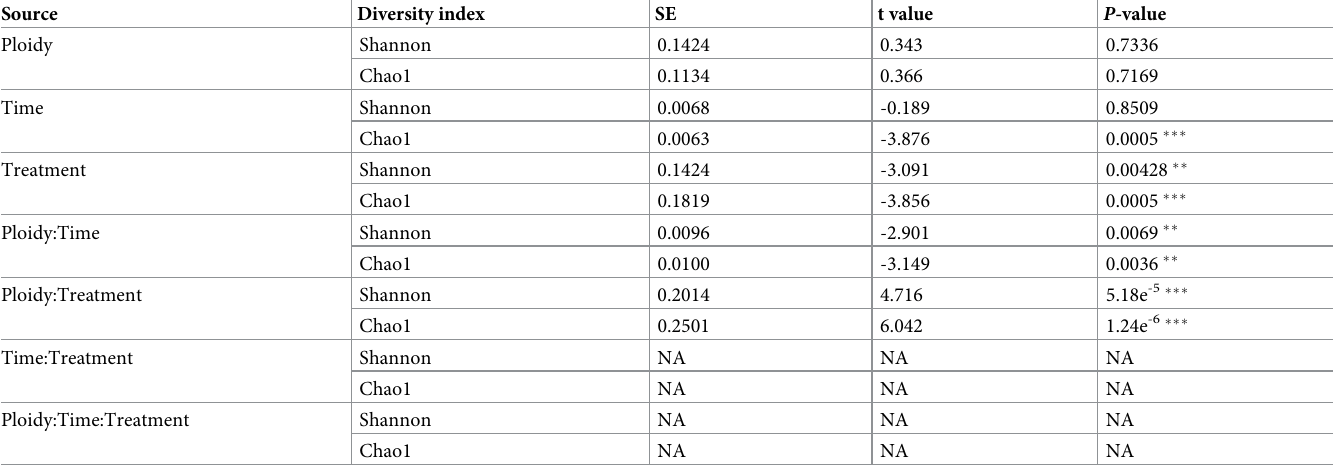
Table 1. Mixed model ANOVA analysis of Shannon Diversity Index, and Chao1 in skin of diploid and triploid salmon. Source